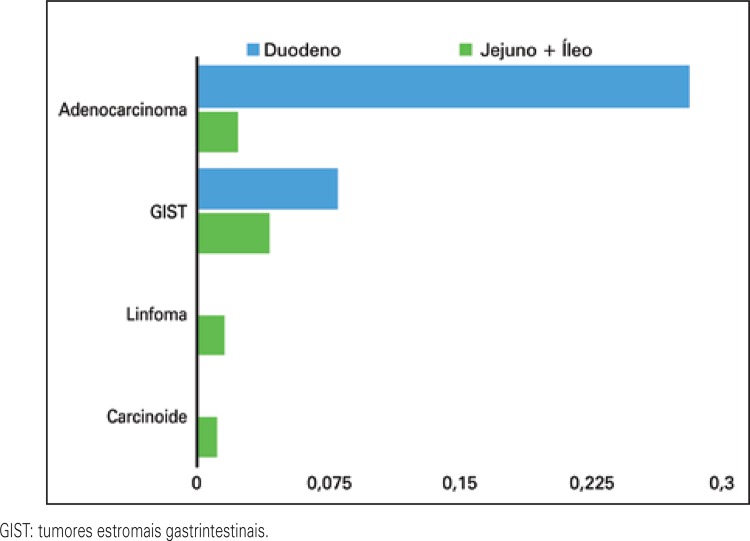
Frequência observada de tumores do intestino delgado correlacionada ao comprimento anatômico do duodeno versus jejuno e íleo